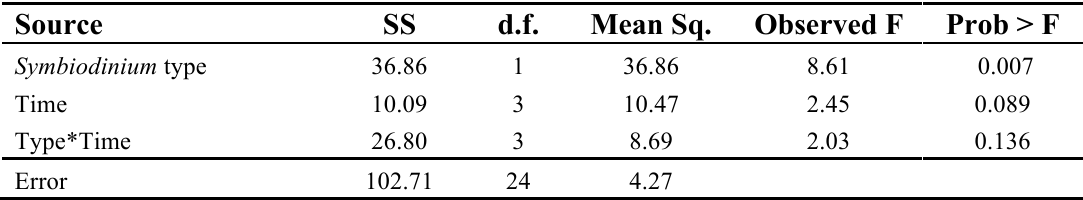
Table 3. Two-factor orthogonal ANOVA comparing the proportion of dead C1 and D Symbiodinium cells among sampling times (0, 24, 48 and 72